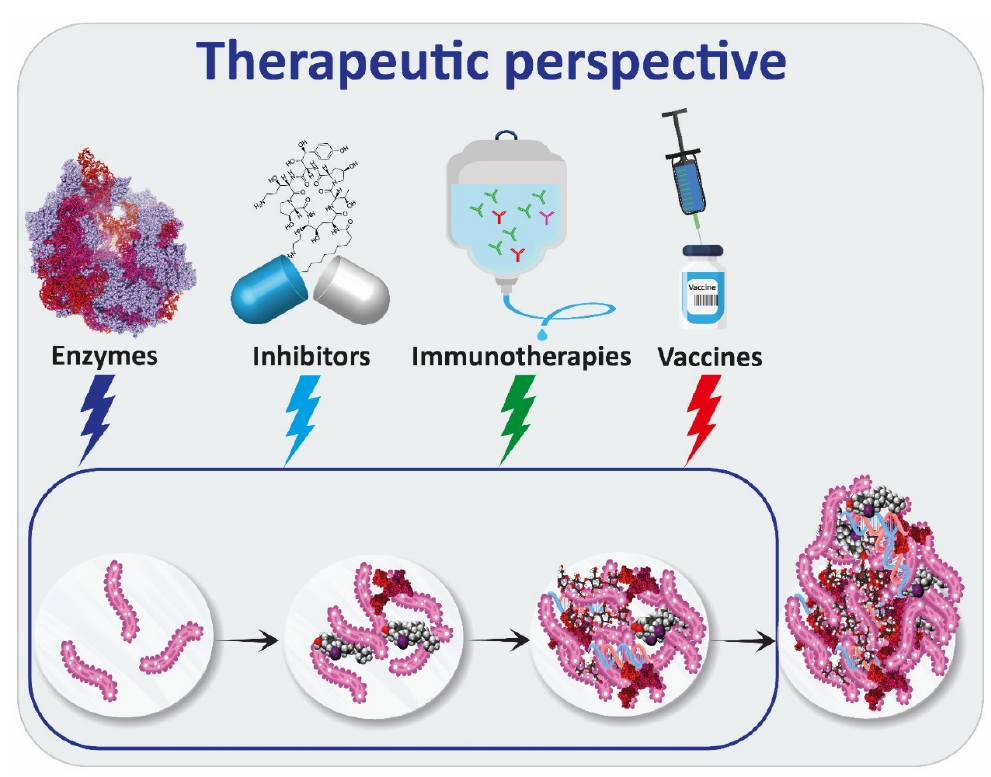
Figure 2. Summary of therapies targeting exopolysaccharides in